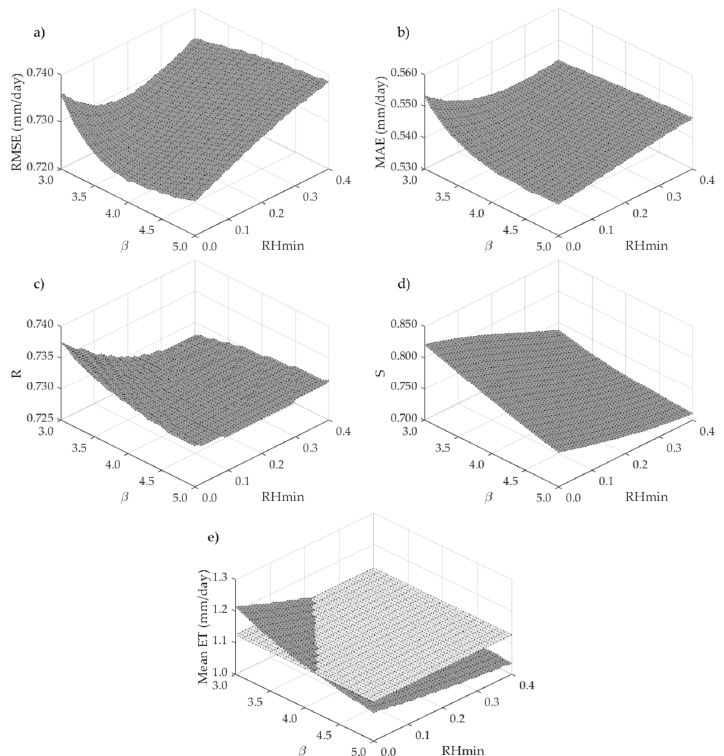
Figure 5. Relationships between mean error metrics ( a – d ) over the period of 2000–2006 from all study sites with the constants ( RHmin and β ) in Equation (4); ( e ) comparison between mean daily ET met (shaded surface) and mean daily ET obs (plain surface) over the period of 2000–2006 for all study sites.